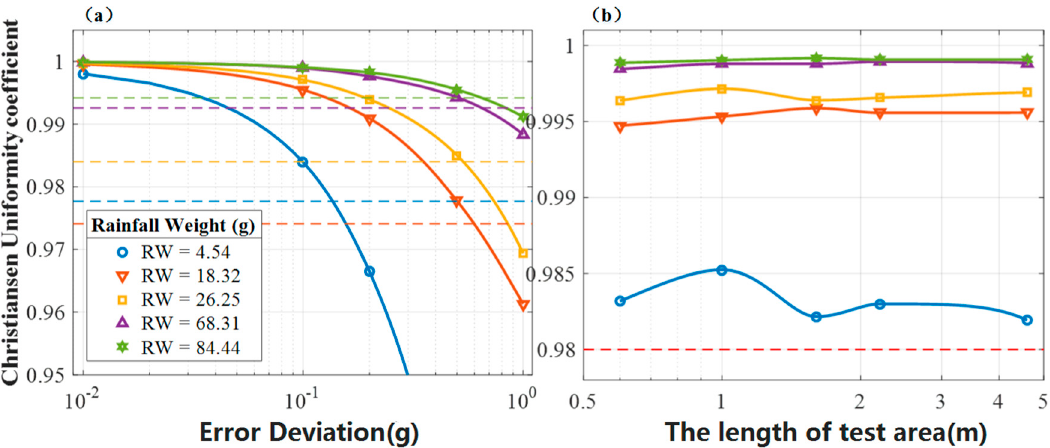
Figure 5. The relationships between CU and ( a ) the average rainfall weight and error deviation, and ( b ) the average rainfall weight and length of the test area. ( a ) CU changes with respect to the average rainfall weight and deviation at the 2.2 m scale; the five deviations are 0.01 g, 0.1 g, 0.2 g, 0.5 g, and 1.0 g. The colored dashed lines refer to the test CU values with certain rainfall weights shown in Table 1. ( b ) CU changes with respect to the average rainfall weight and length of the test area, with a deviation of 0.2 g. The five lengths are 0.6, 1.0, 1.6, 2.2, and 4.6 m.